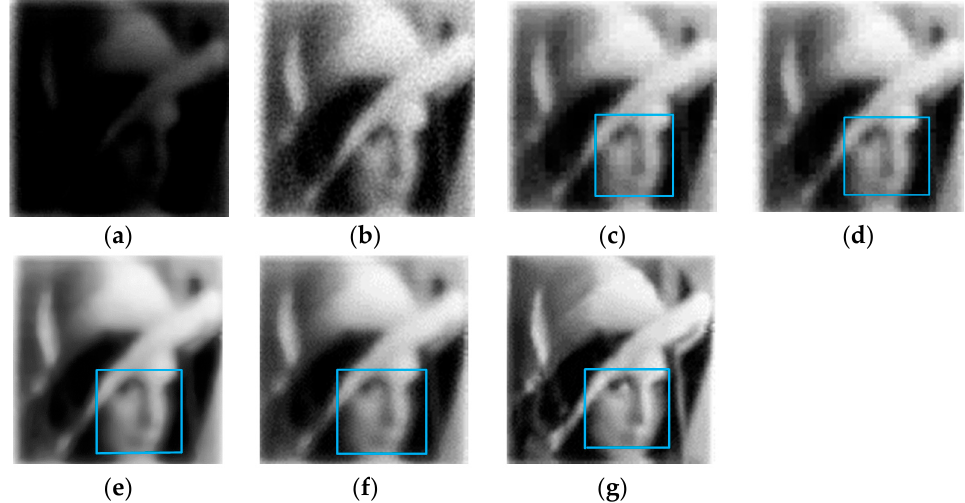
Figure 8. Comparison of different algorithms’ denoising effect on the Lena photon counting image (detected under 4.17 × 10 − 4 lux environment with a scan resolution of 120 × 120). ( a ) Photon counting image; ( b ) reconstruction by HE; ( c ) reconstruction by WA-based HE; ( d ) reconstruction by WA-FICA-based HE; ( e ) reconstruction by NSCT-based HE; ( f ) reconstruction by BM3D -based HE; ( g ) reconstruction by proposed algorithm. The decomposition layer was 4, the direction number was 4, 8, and 16 in NSCT and the block size was 6, the sliding step to process every next reference block was 3, the maximum number of similar blocks was 16, the threshold for the block-distance was 2000, and the filtering parameters are referred to in the literature [39].